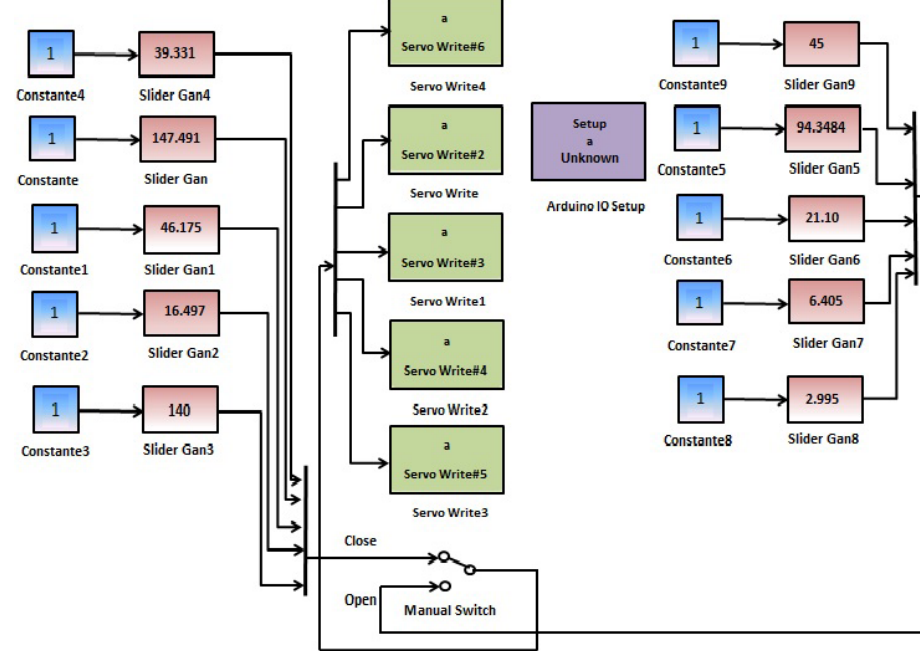
Figure 5. Proposed design and wiring for test hand robot open and close